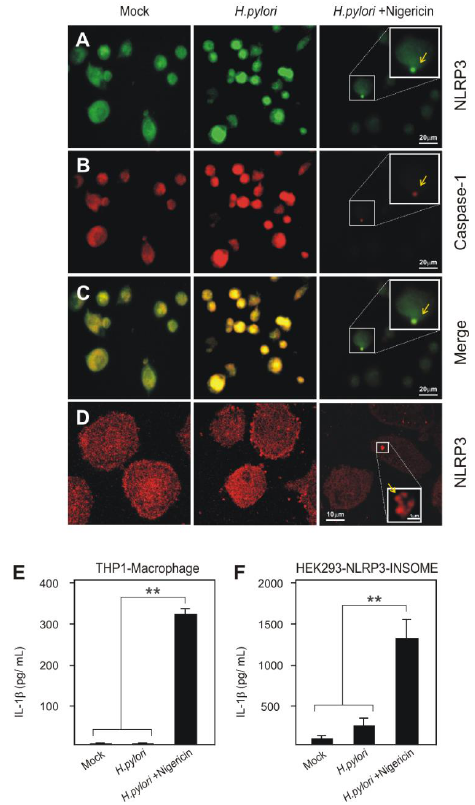
Figure 5. The immunofluorescence images of NLRP3, caspase-1 and merged in H. pyloi- infected, H. pyloi /Nigericin-treated and mock treated control cells of PMA differentiated THP1 macrophages ( A – C ). The NLRP3 inflammasome formation is indicated with yellow arrows. The super resolution STED microscopy of the NLRP3 and inflammasome formation in H. pyloi- infected, H. pyloi /Nigericin-treated and mock treated control cells with more clarity showing donut-shaped inflammasome speck ( D ). The mature IL-1β secretion from THP1 macrophages and reconstructed HEK293-NLRP3-INSOME secretion after infection and Nigericin treatment were determined in parallel by ELISA ( E , F ). ** p ≤ 0.01